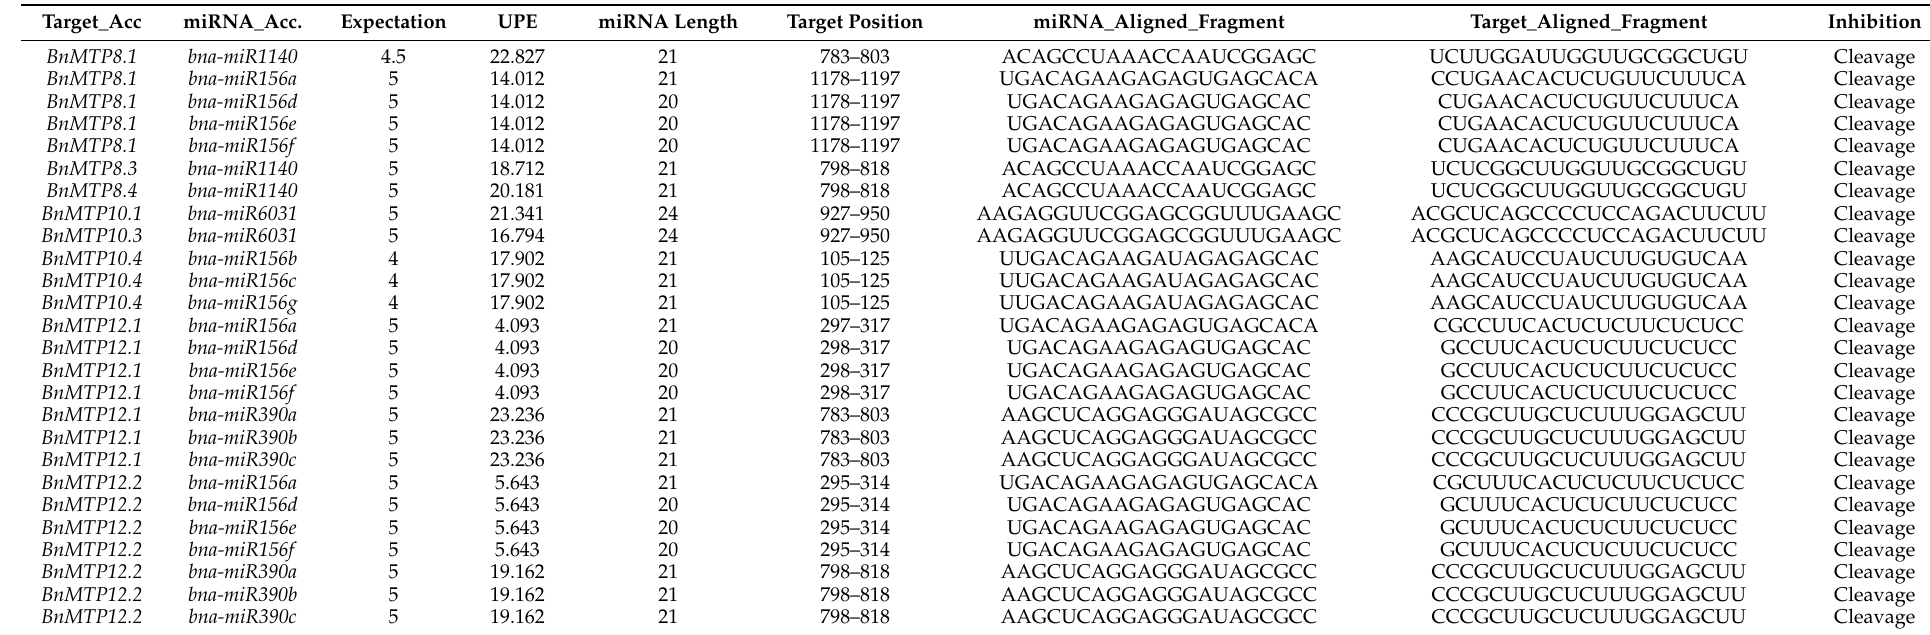
Table 1. The potential miRNA target sites in BnMTP